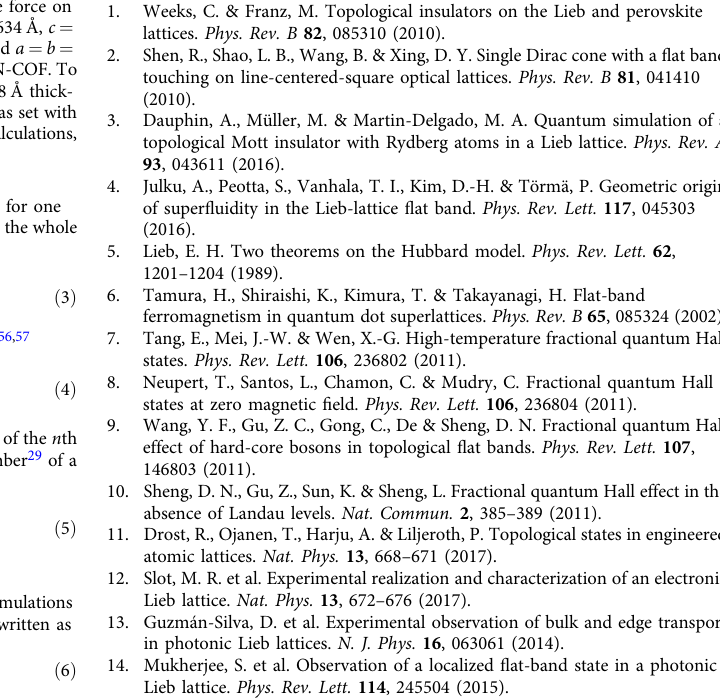
h for monolayer